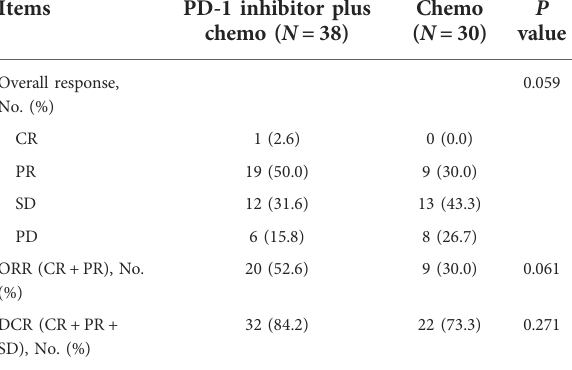
TABLE 3 Treatment